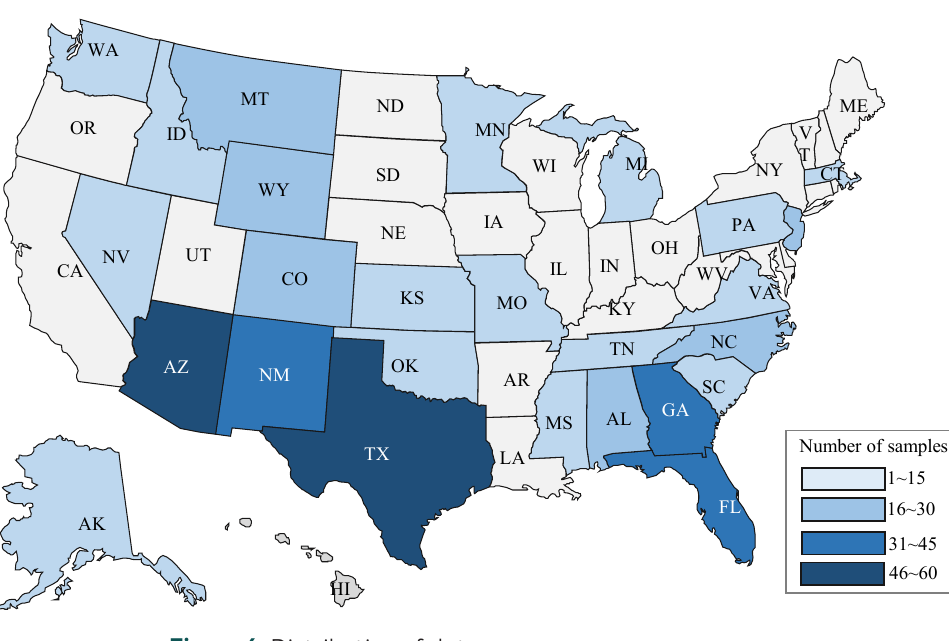
Figure 6. Distribution of data